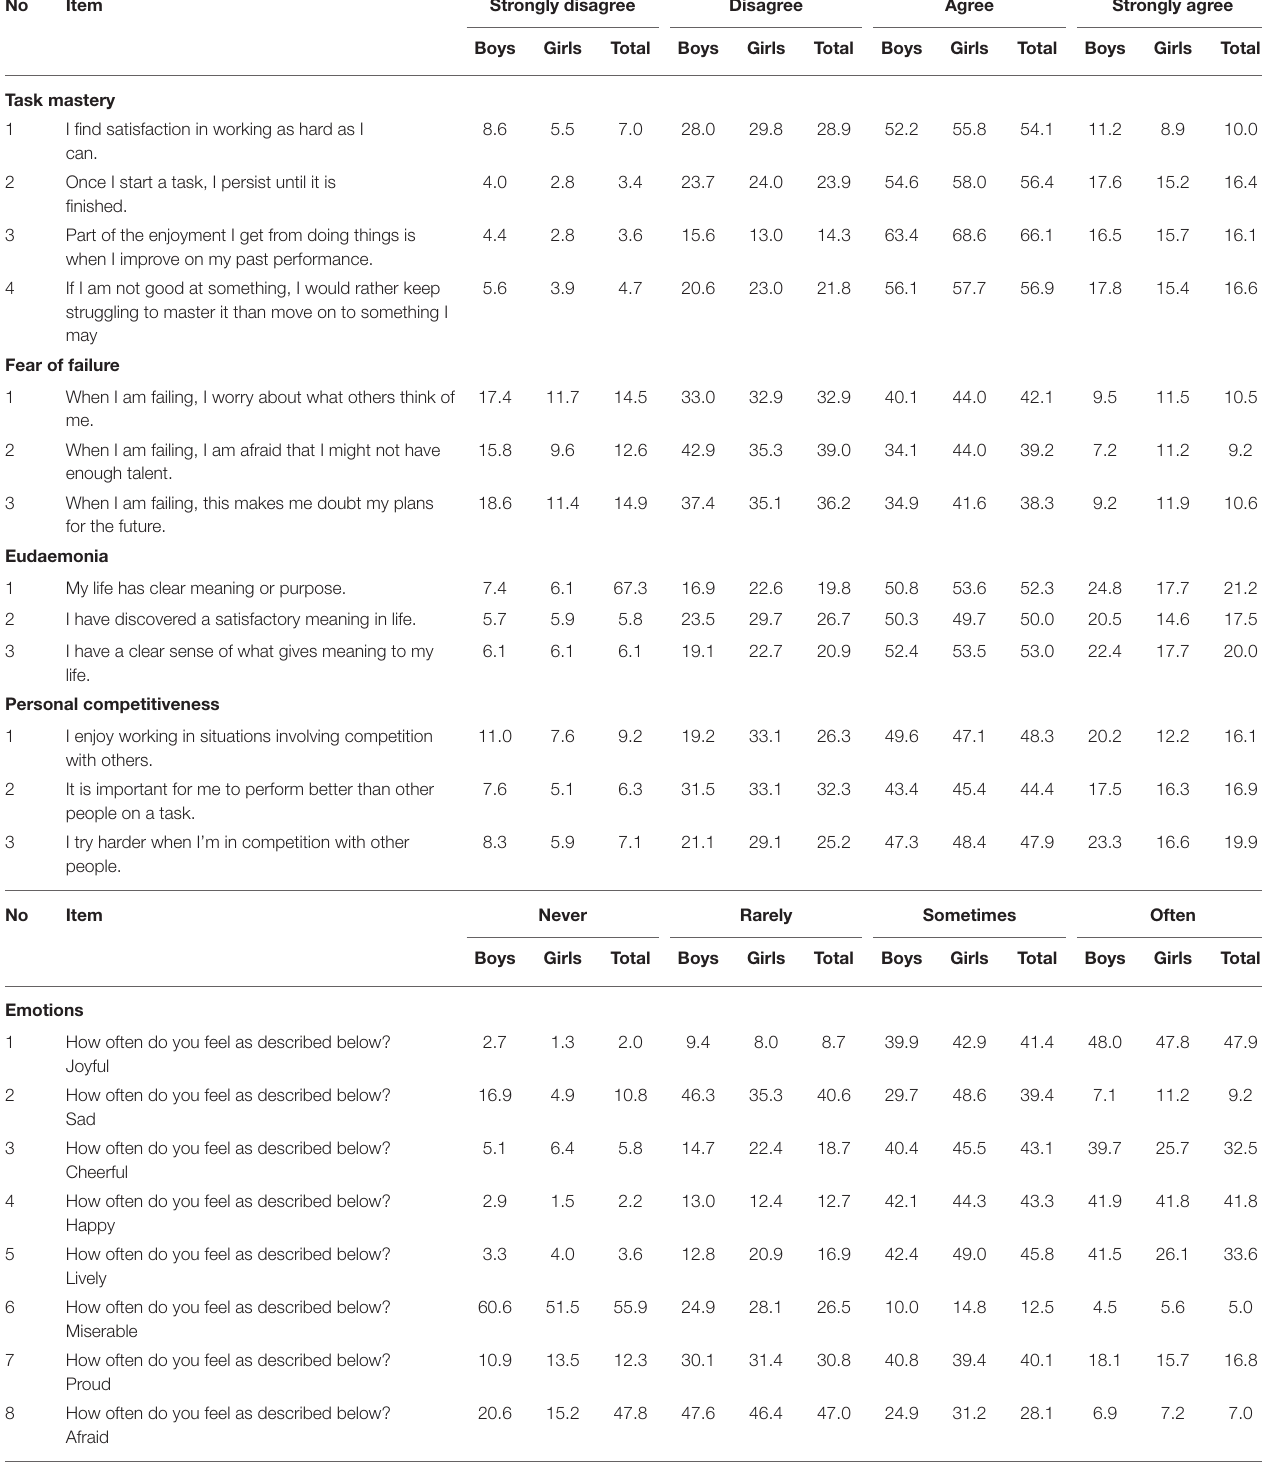
TABLE 3 | Summary statistics of the